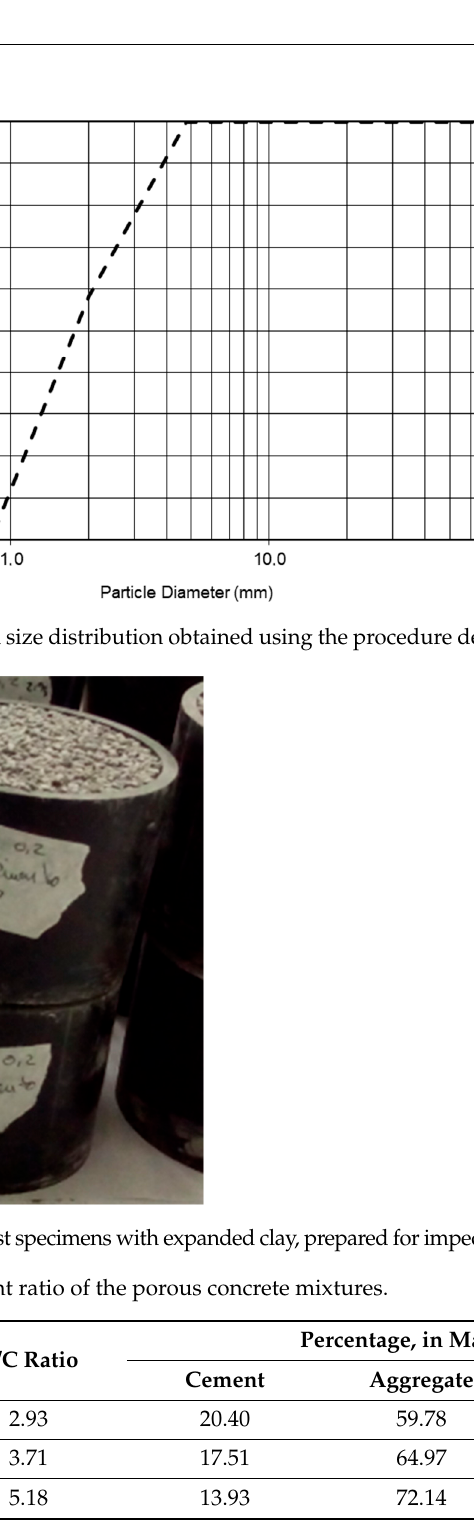
Table 1. Aggregate/Cement ratio of the porous concrete mixtures.